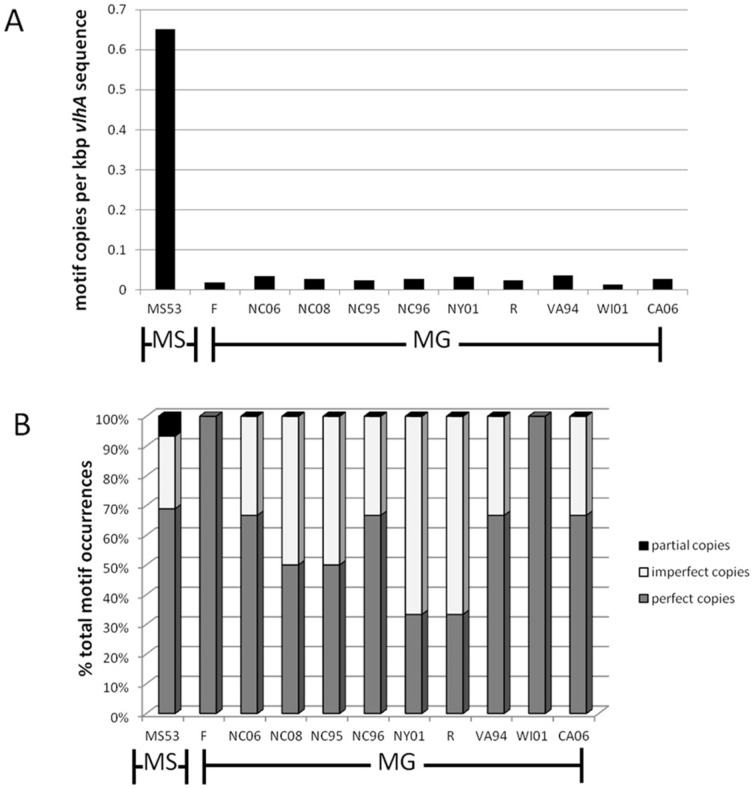
PHM distribution in vlhA genes and pseudogenes in M. synoviae and M. gallisepticum.(A) PHM-encoding sequence as a function of total kbp of vlhA sequence is elevated 18-fold in M. synoviae (MS) reference strain MS53, the only strain for which the entire vlhA locus sequence has been published, relative to 10 fully-sequenced strains of M. gallisepticum (MG), evidence that it is far more common in M. synoviae. (B) The relative proportions of perfect and imperfect PHM copies were comparable between strains of M. synoviae and M. gallisepticum.